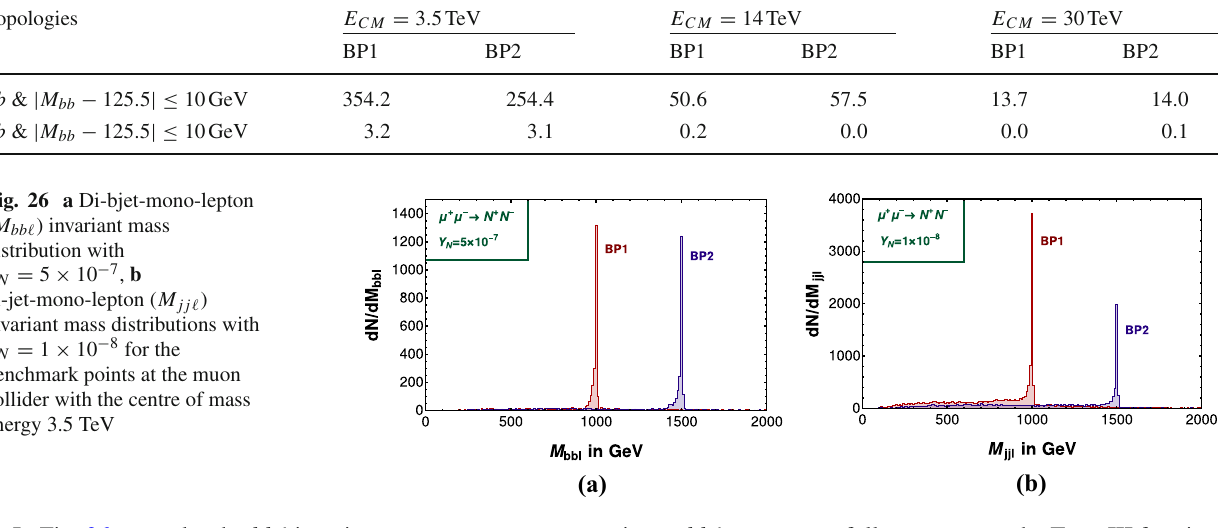
centre of mass energies of 3.5TeV, 14TeV and 30TeV at the inte- gratedluminositiesof( L int = )1000fb − 1 ,10,000fb − 1 and30,000fb − 1 , respectively with Y N = 5 × 10 − 7